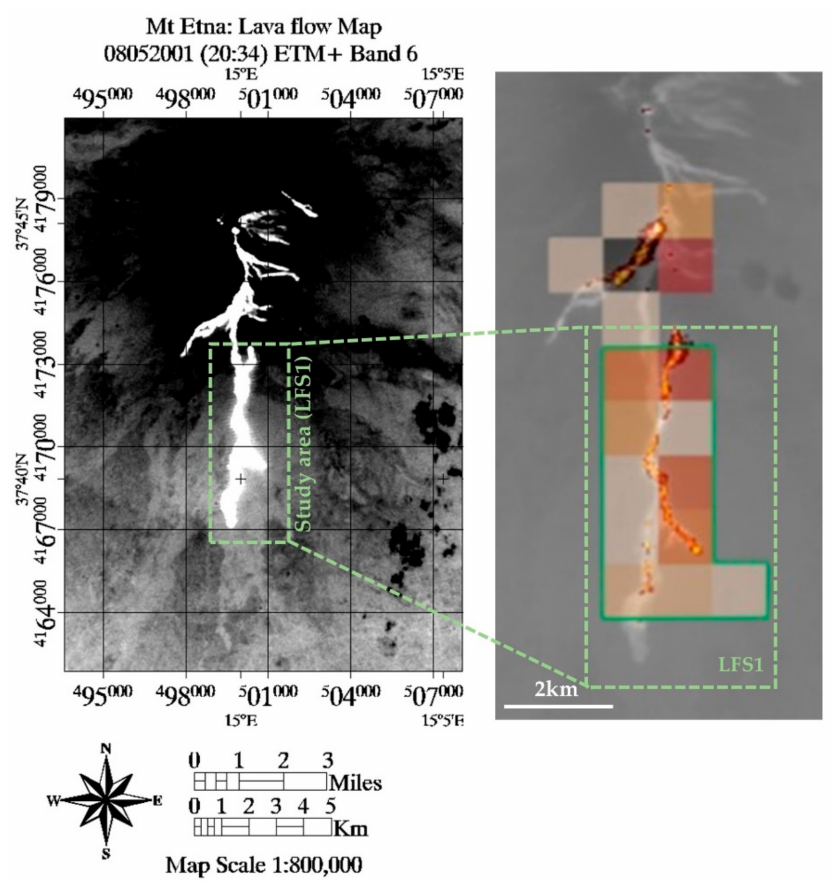
Figure 13. ( left ) Study area (LFS1) [7] indicated on a ETM+ TIR (Band 6) image, used here for visual presentation purposes alone; ( right ) hotspot pixels derived from MODIS data, acquired on 5 August at 21:10 UTC, superimposed on the Landsat 7, Band 7 data acquired on 5 August at 20:34 UTC, as SWIR Bands (5 and 7) were used for ETM+ computation of radiant heat flux. MODIS pixel colours are related to the value of radiant heat flux (e.g., bright red—high values, pale red—low values). The dashed green line indicates the extent of LFS1 study area, whereas the solid green border line marks MODIS pixels relating to ETM+ radiant pixel area in Band